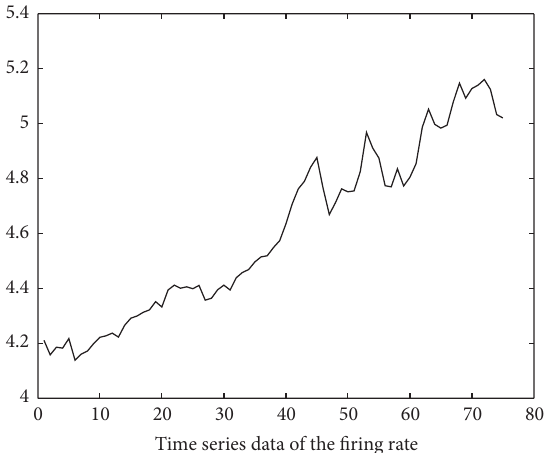
Figure 15: Firing rate series of PutInCart.